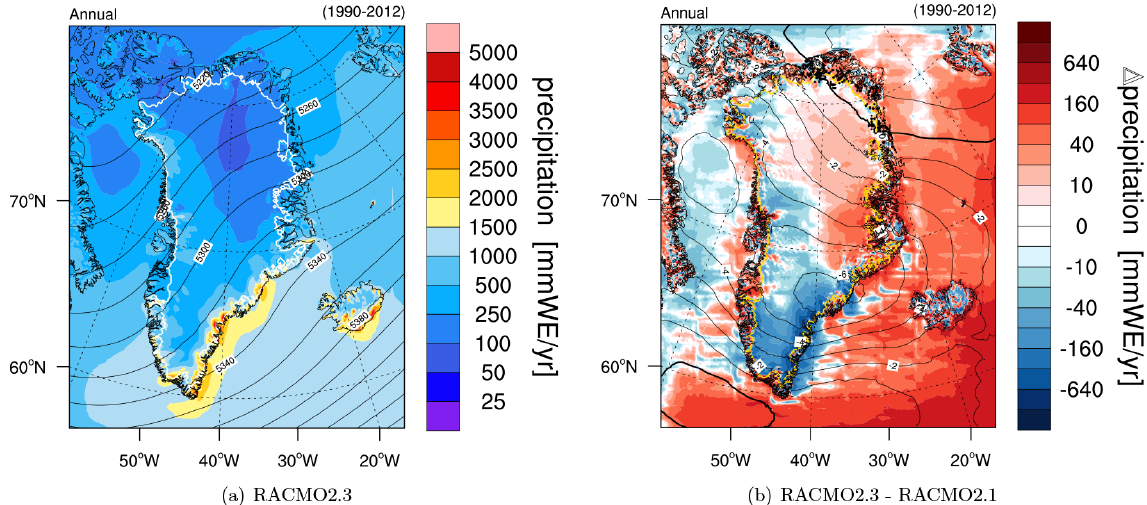
Figure 3. (a) Mean annual total (rain and snow) precipitation (mmWEyr − 1 ) and 500 hPa geopotential height (m) in RACMO2.3; (b) change in mean annual total precipitation (mmWEyr − 1 ) and 500hPa geopotential height (m) between RACMO2.3 and RACMO2.1